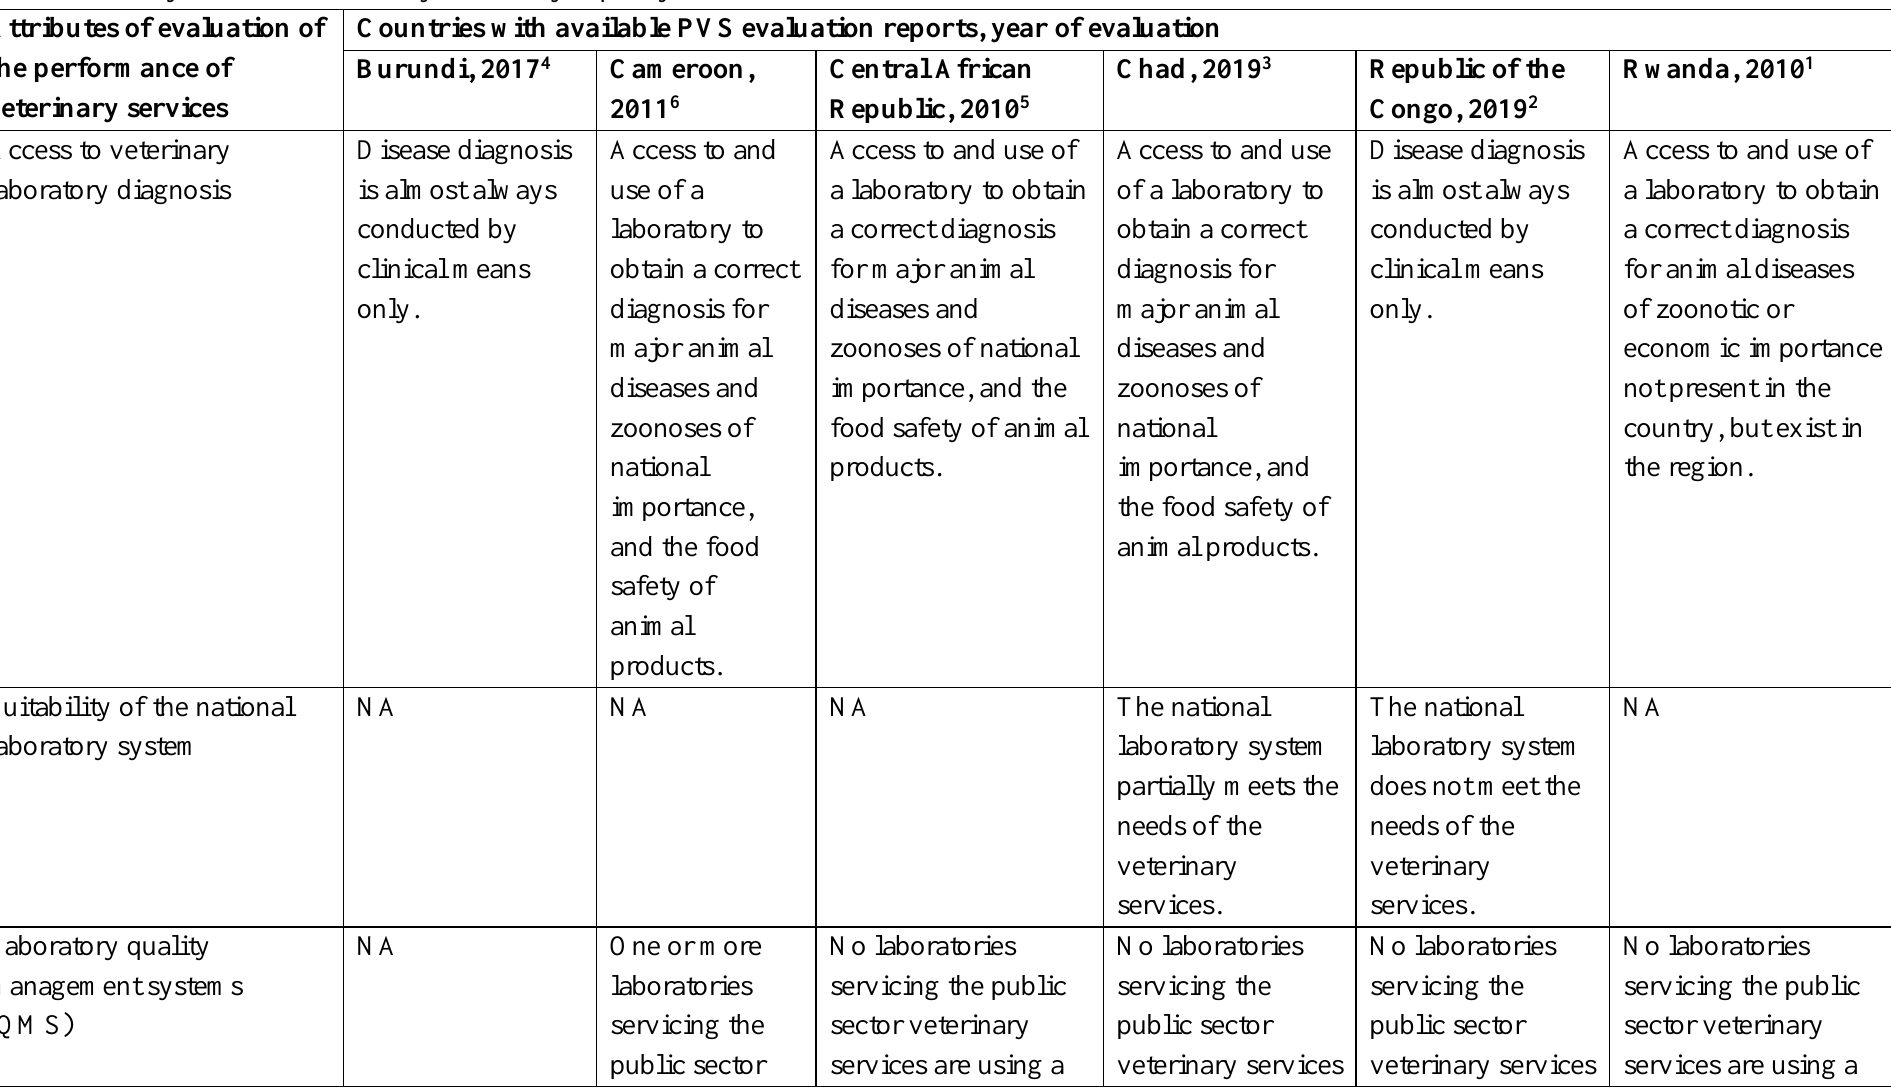
Table 1. Country scores for veterinary laboratory capacity in the